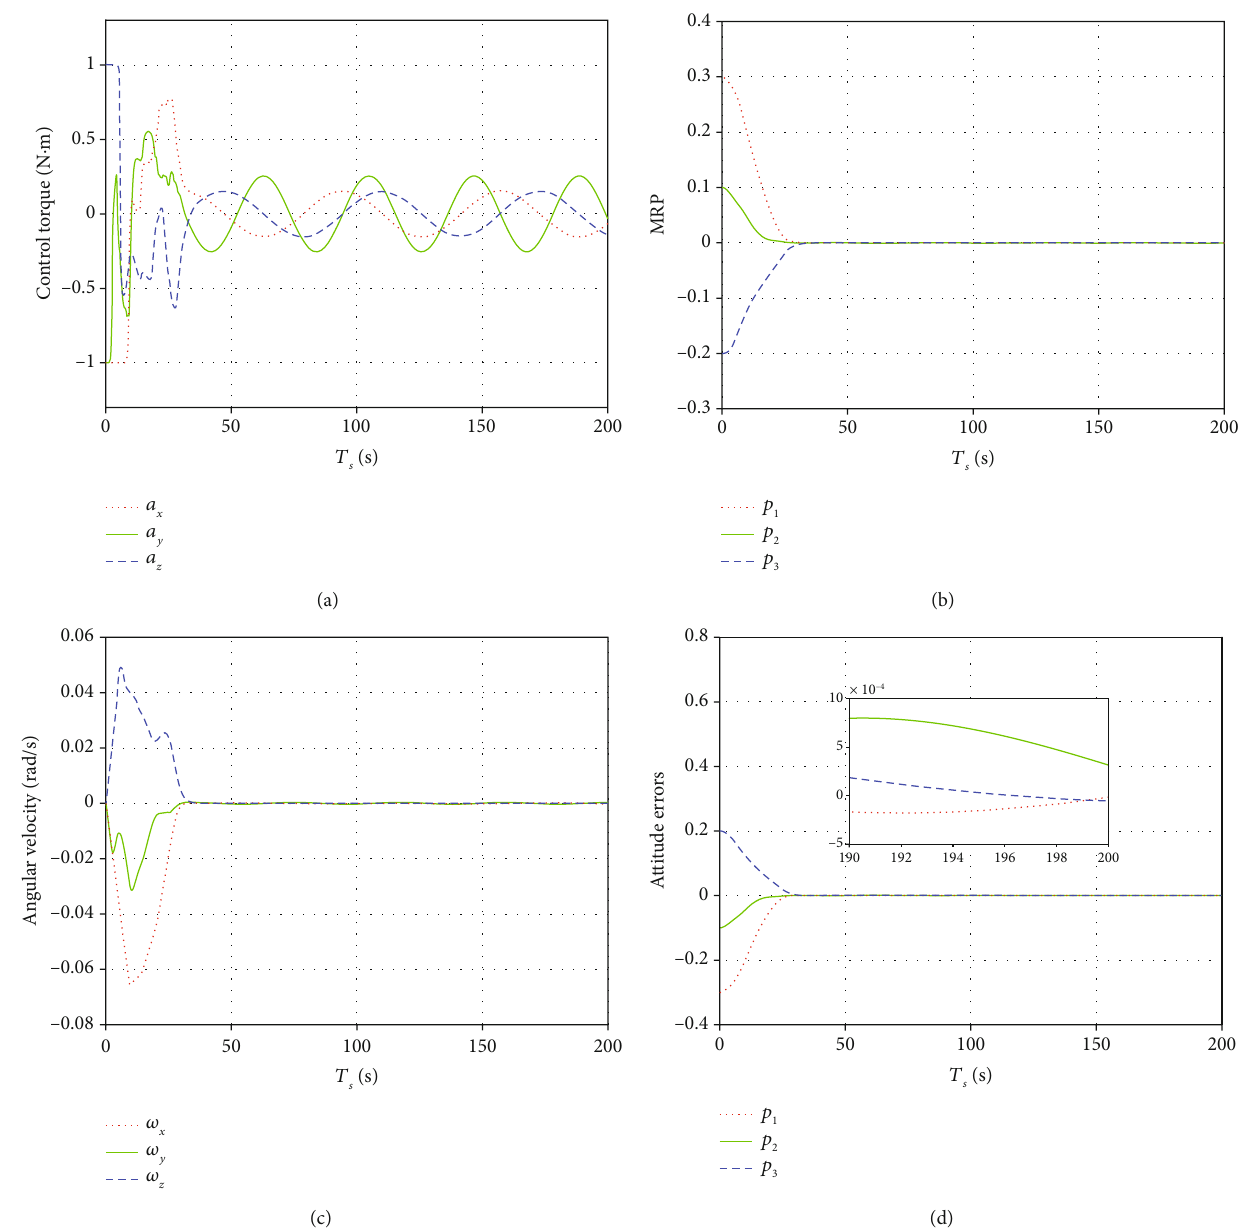
Figure 8: Attitude stabilization using the DRL controller under unknown external disturbances: (a) time response of control torque; (b) time response of MRP; (c) time response of angular velocity; (d) the attitude error